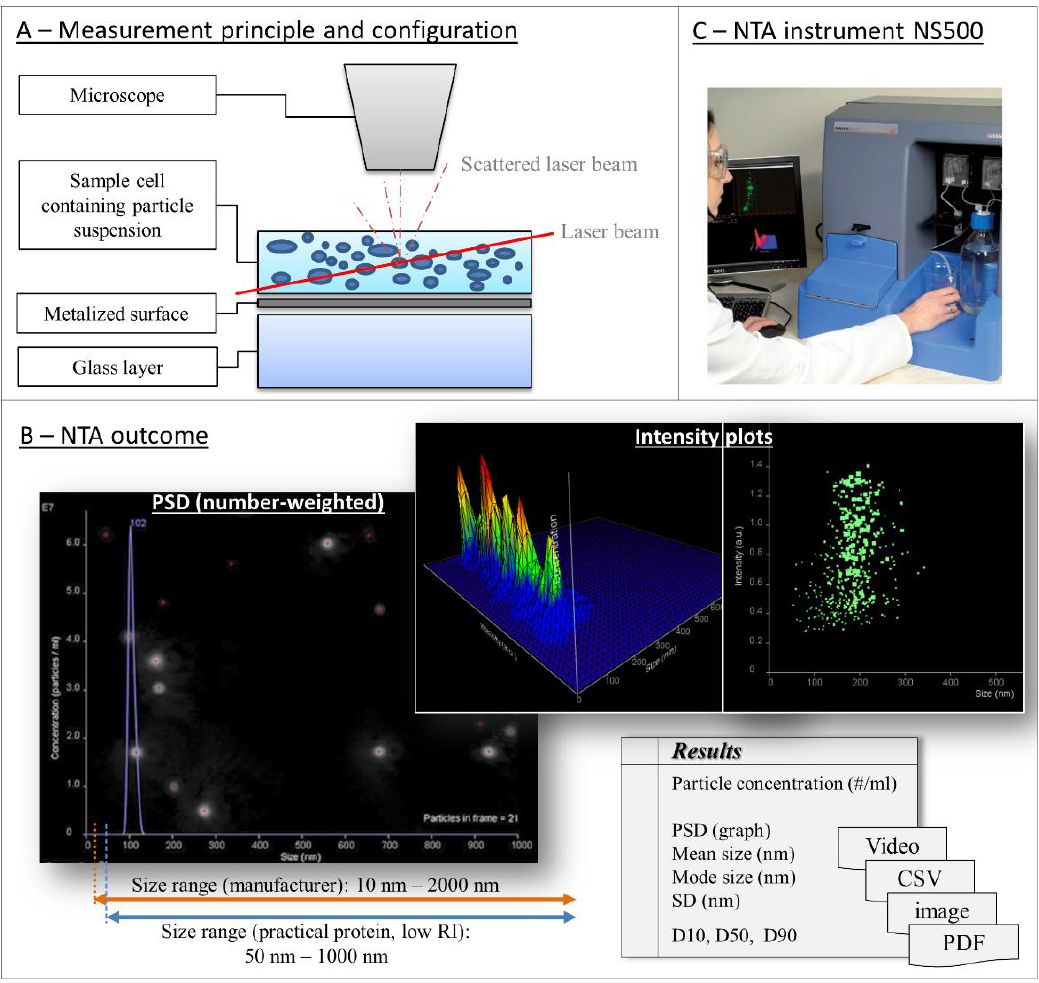
Figure 4. Nanoparticle tracking analysis (NTA): instrument, measuring principle, and final outcome. ( A ) Schematic illustration of the measurement principle of the NTA instrument (Nanosight Ltd.). The particle suspension is pumped into the sample cell where the laser beam encounters the particle causing light scattering. The light scattering centers of each particle are recorded and afterwards used to determine the Brownian motion of each particle indirectly by the motion of the scatter center. ( B ) Example of a measurement result using the provided instrument software. The recorded scattering centers are tracked and finally the number-weighted PSD, 2D and 3D intensity plots and a total particle concentration are provided. The results are obtained as video file, graph image files, text file (.csv), and PDF-file. ( C ) NTA instrument NS500 (Nanosight Ltd.). Adapted with permission from [195], Elsevier, 2011.